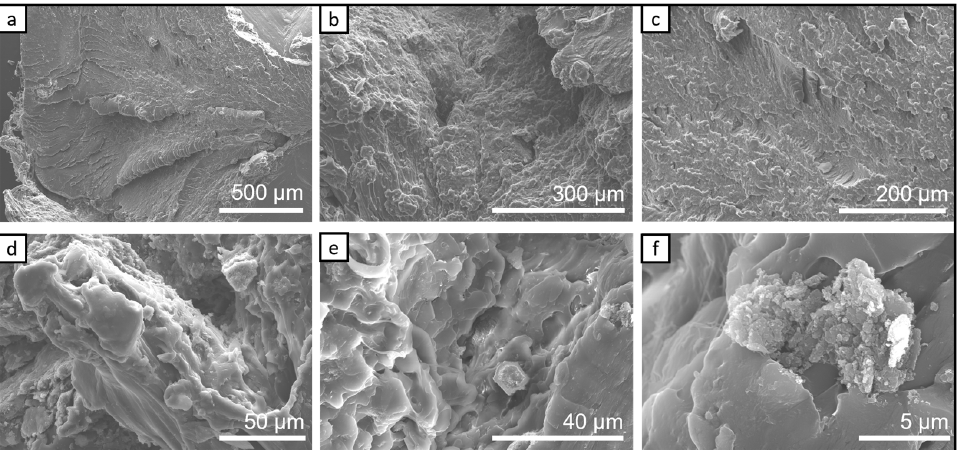
Figure 5. Representative SEM micrographs of bio-PA1010 filled with 4% C500 graphene nanoplatelets after thermal treatment at 80 °C ( a ); low magnification images of the sample with progressive magnification showing the smooth surface and embedded graphenic aggregates ( b – f ).